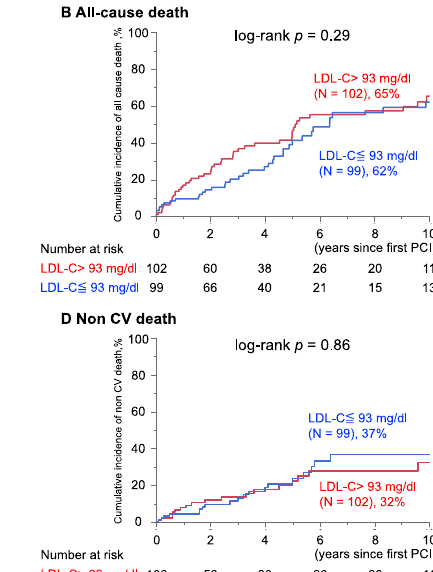
Figure 1. Cumulative cardiovascular event rates in groups with and without statins. Significantly reduced cumulative incidences of ( A ) CV death, ( B ) All-cause death, and ( C ) 3P-MACE were ob- served in patients with statin therapy at PCI, while no difference in ( D ) Non CV death was seen. Percent indicates the cumulative incidence of events at 10 years of follow-up in each group.